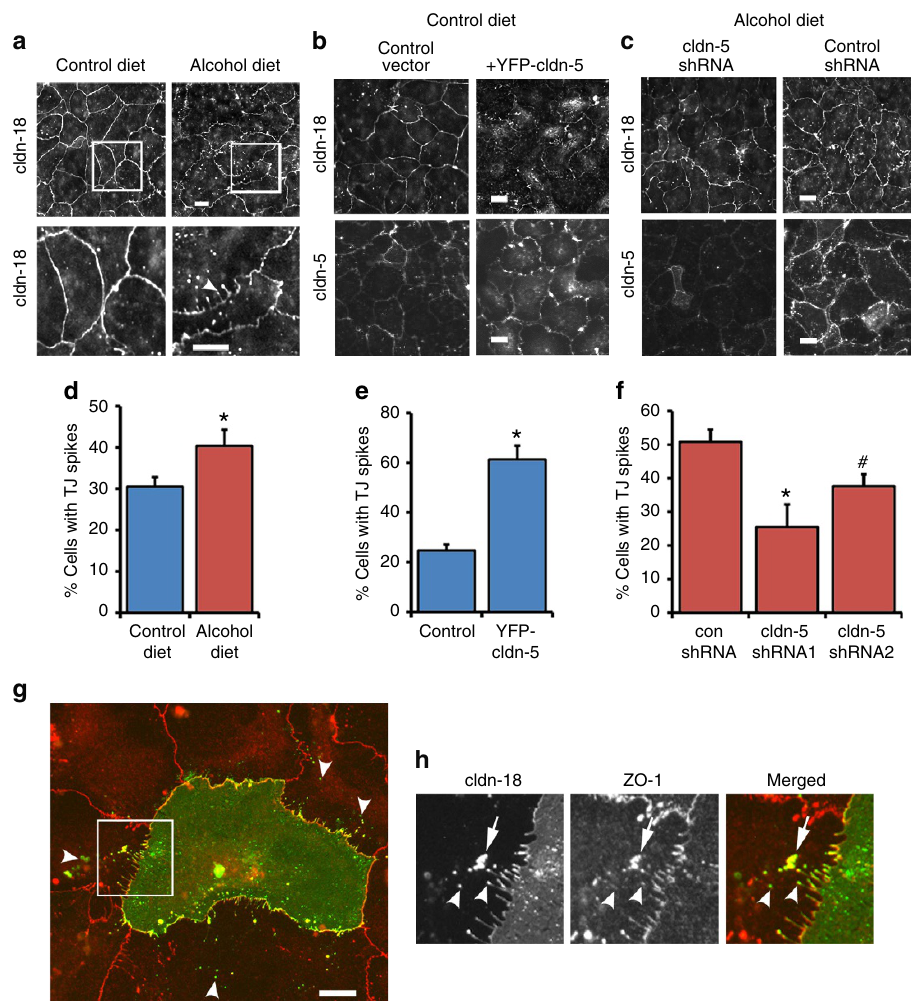
Figure 2 | Increased claudin-5 expression enhances the formation of tight junction spikes. AECs isolated from alcohol or control fed rats were cultured for 5–7 days on transwell permeable supports and immunolabeled for claudin-18. ( a ) Cells from alcohol fed rats showed enhancement of tight junction spikes, that are claudin-18 projections perpendicular to the cell-cell interface (d; arrowhead). Square regions in the top panels correspond to magnified images in below (Bar, 10 m m). ( b ) Control AECs transduced with YFP-claudin-5 increased the appearance of tight junction spikes as determined by labeling for cldn-18 or cldn-5 (Bar, 10 m m). ( c ) Alcohol-exposed AECs transduced with claudin-5 shRNA had a decrease in tight junction